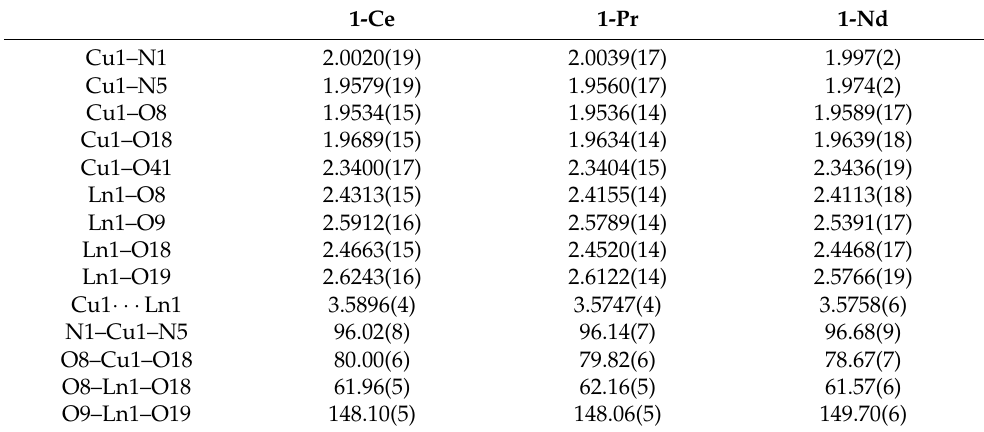
Table 1. Selected bond lengths (Å) and angles (degrees) for compounds 1-Ce , 1-Pr , and 1-Nd .